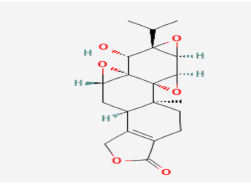
Figure 5. Chemical Structure of Triptolide (PubChem